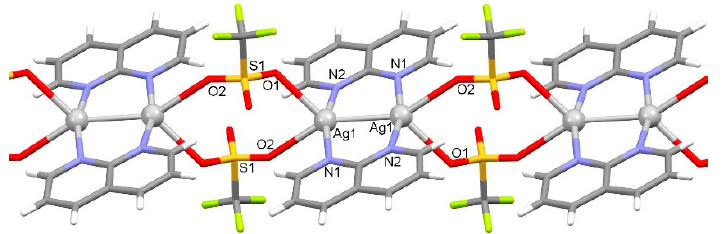
Figure 3. Polynuclear chain in Ag2